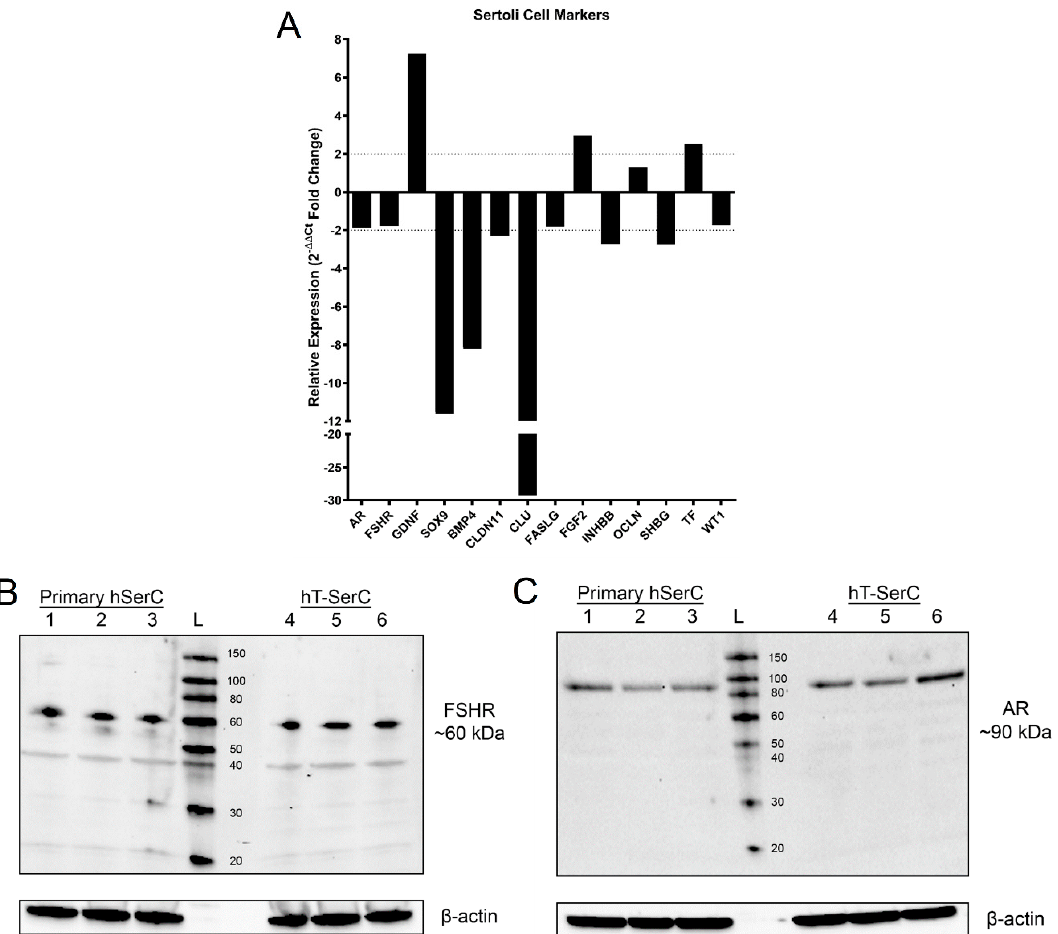
Figure 3. ( A ) Relative mRNA expression of various human SC marker genes assessed by RT-qPCR using the 2 − ∆∆ Ct method. Ct values were normalized to GAPDH as the reference gene. ( B ) Representative Western blot of three independent experiments for the expression of human FSHR in primary human SCs at passages 4–6 (lanes 1–3) and post-passage 20 hT-SerCs (lanes 4–6). ( C ) Representative Western blot of three independent experiments for the expression of human AR in primary human SCs at passages 4–6 (lanes 1–3) and post-passage 20 hT-SerCs (lanes 4–6). The molecular weight ladder is denoted as L. Beta-actin served as the loading control.